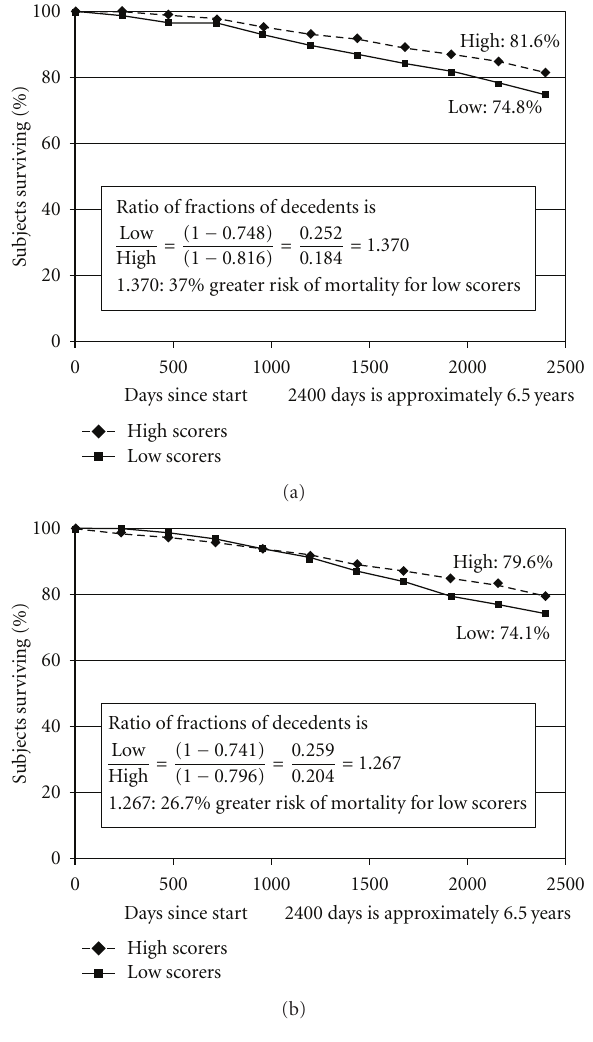
Figure 2: (a) Survival in the groups with high and low scores on future time perspective over approximately 6.5 years. (b) Survival in the groups with high and low scores on future self-continuity over approximately 6.5 years.